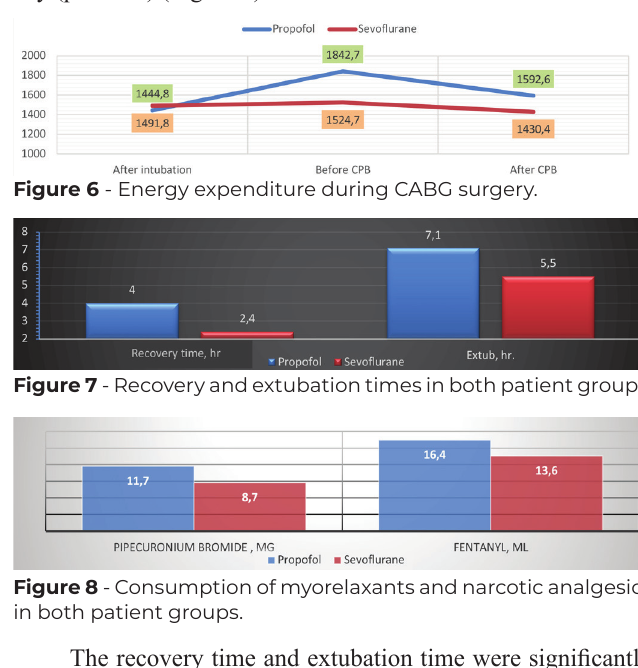
anaesthetic 16.4±3.8 milligrams and 13.6±3.3 ml respectively (P=0.01) (Figure